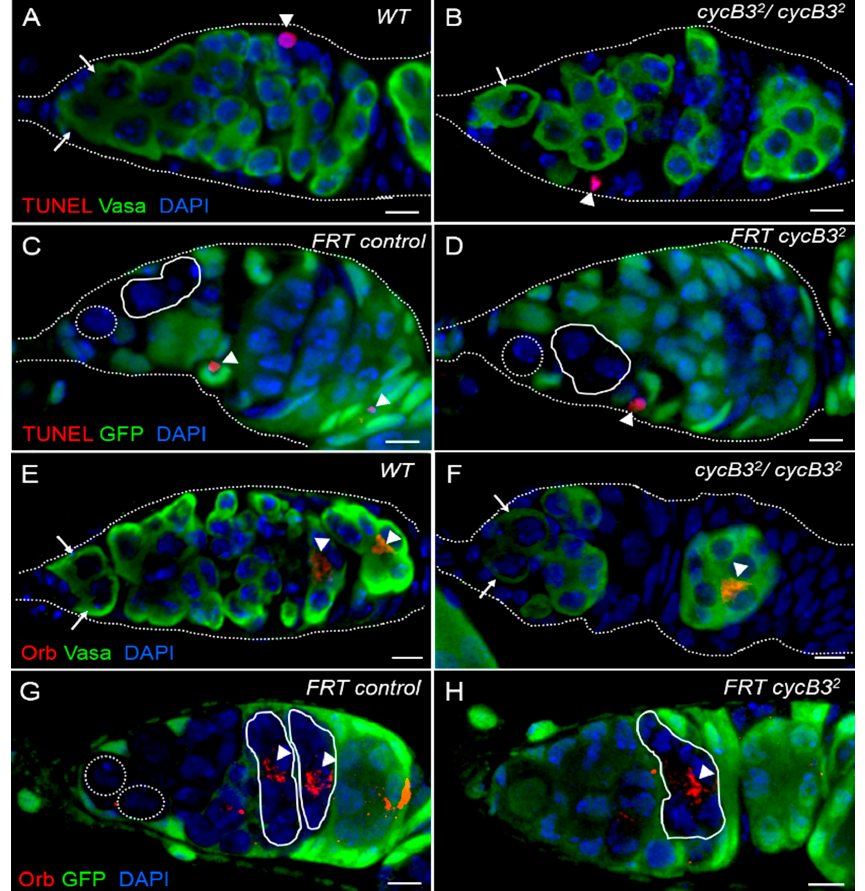
Figure 6. The mutation in cycB3 fails to affect oocyte formation. ( A – D ) The deficiency of cycB3 fails to lead to apoptosis in GSCs. Germaria from wild-type ( A ) and cycB3 2 mutants ( B ) were labeled by TUNEL (red, indicated by arrowheads) and stained with anti-Vasa antibody (green) and DAPI dye (blue); Germaria from FRT controls ( C ) and FRT cycB3 2 mutants ( D ) were labeled by TUNEL (red, indicated by arrowheads), stained with anti-GFP antibody (green) and DAPI (blue); ( E – H ) The cycB3 mutation in CB fails to impair its differentiation into oocytes; Germaria from wild-type ( E ) and cycB3 2 mutants ( F ) were stained with anti-Orb antibody (red, indicated by arrowheads), anti-Vasa antibody (green) and DAPI (blue). The outlines of germaria are drawn by dashed circles. Germaria from FRT controls ( G ) and FRT cycB3 2 mutants ( H ) were stained by anti-Orb antibody (red, indicated by arrowheads), anti-GFP antibody (green) and DAPI (blue). GSCs are noted by arrows ( A , B , E , F ); GSC clones are indicated by dashed circles and cyst clones are noted by solid circles ( C , D , G , H ). The outlines of germaria are drawn with dashed circles ( A – F ). Scale bars: 5 μ m.